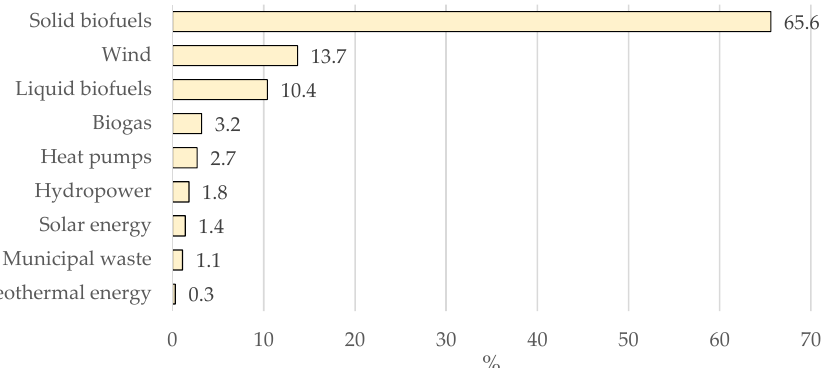
Figure 2. Structure of generated renewable energy by types of installations in Poland in 2019. Source: